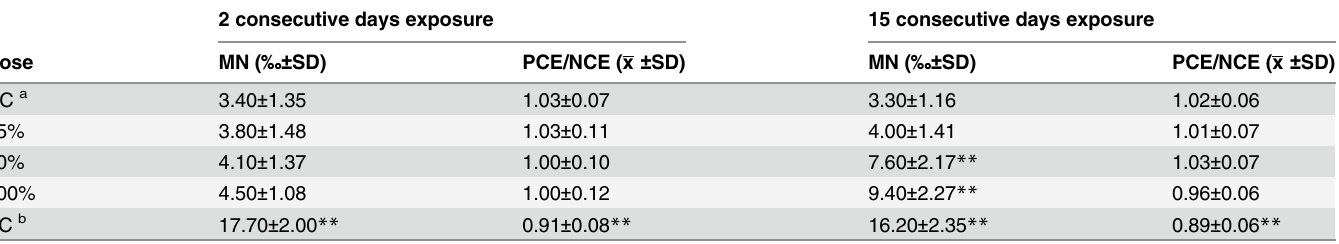
Table 3. Micronucleus frequencies of PCEs in mouse bone marrow induced by the irrigative wastewater taken from the Dongming discharging river in Shijiazhuang city (n = 10).